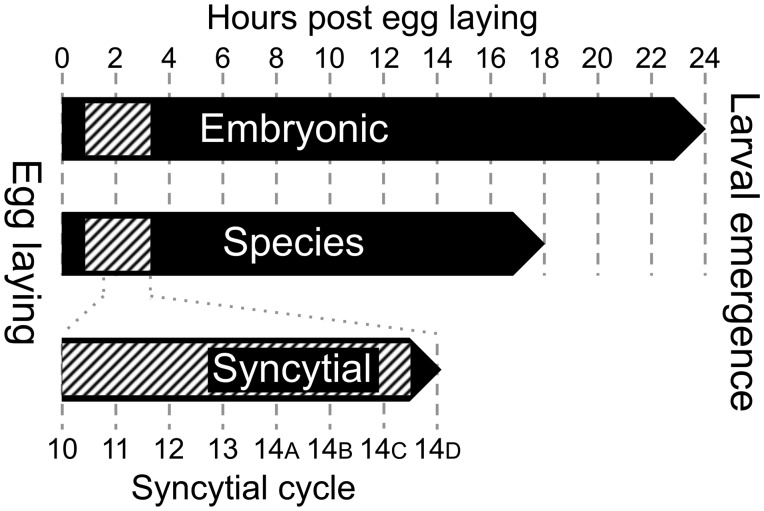
Correspondence between the three expression timecourses analyzed in this study: Embryonic (Gravely et al. 2011), species (Kalinka et al. 2010), and syncytial (Lott et al. 2011). Both the embryonic and species timecourses consist of pools of embryos collected at 2-h intervals, spanning either 24 or 18 h of Drosophila embryogenesis. The syncytial timecourse spans syncytial cycles 10–13, followed by four collections during the extended 14th cycle corresponding roughly to 25% increments of cell wall extension to completion of cellularization (indicated by A–D). The correspondence between the syncytial timecourse and the other timecourses is indicated by the gray dotted line. The hashed area indicates the period during which the rapid syncytial divisions take place (timing is taken from Campos-Ortega and Hartenstein 1985). The embryonic and syncytial timecourses were generated by RNA-seq, whereas the species timecourse was generated using microarrays.